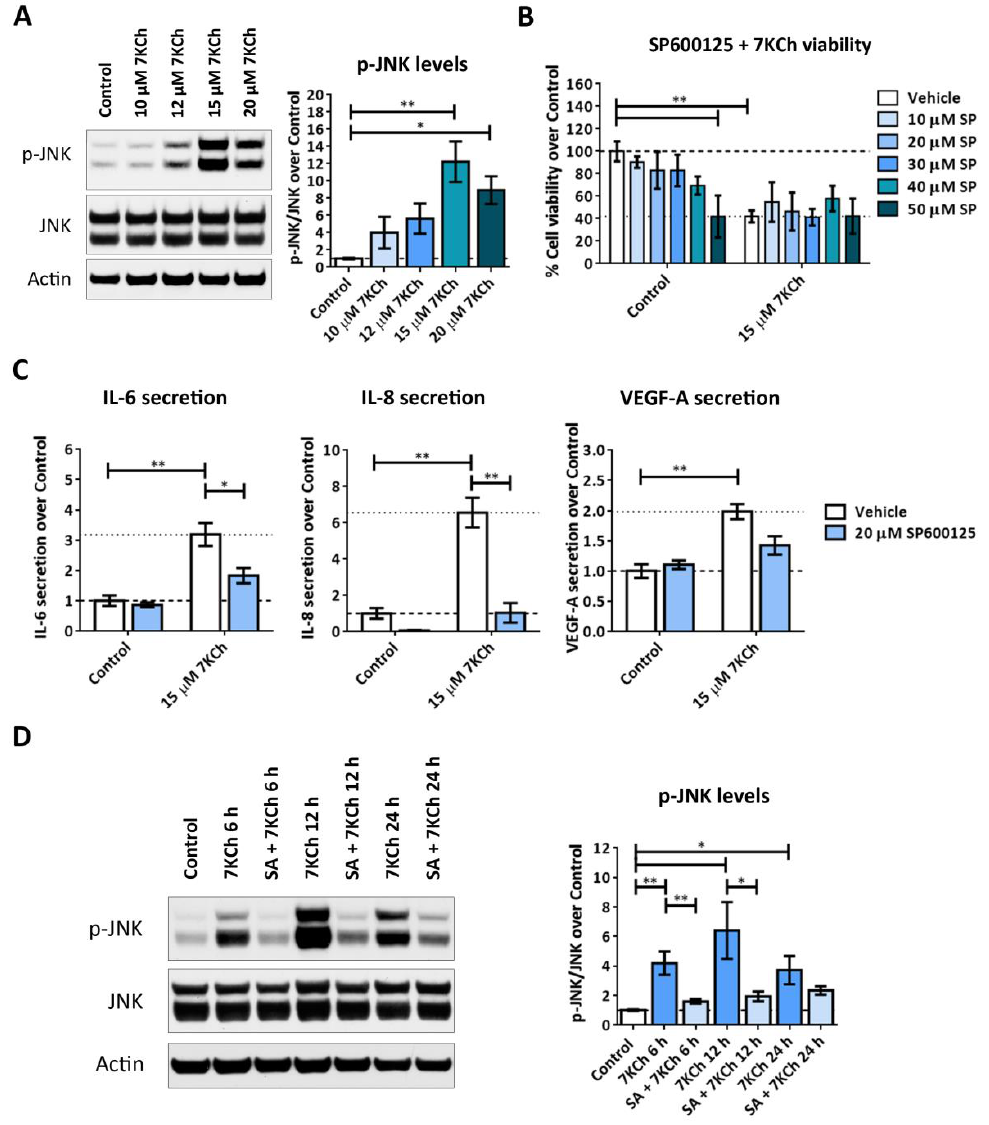
Figure 8. Activation of JNK in response to 7KCh in mRPE cells. ( A ) Western blot estimation of phosphorylated JNK (p-JNK) levels in mRPE cells exposed to increasing concentrations of 7KCh for 24 h. ( B ) Cell viability determined by MTS assay in mRPE cells treated with 15 µ M 7KCh and increasing concentrations of SP600125 (SP) for 24 h. ( C ) Secreted levels of IL-6, IL-8 and VEGF-A in mRPE cells exposed to 15 µ M 7KCh and 40 µ M SP600125 for 48 h and measured with ELISA. ( D ) Western blot estimation of p-JNK levels in mRPE cells exposed to 20 µ M 7KCh and 10 µ M SA for 6 h, 12 h and 24 h. In Western blot assays, JNK levels, previously normalized with respect to Actin, were used to normalize p-JNK quantification. In MTS assay and ELISA, the JNK inhibitor SP600125 was added with a pretreatment of 2 h with respect to 7KCh. The vehicle group in the graphs represents the control (control-vehicle) and the 7KCh (7KCh-vehicle) treatment. Data are represented as mean ± SEM of at least three different experiments. The dashed and dotted lines are a guidance mark of control and 7KCh value, respectively. ANOVA test was used for statistical analysis followed by Tukey (in A , B , D ) or Sidak (in C ) post hoc test.* p < 0.05; ** p < 0.01. Regarding p38 phosphorylation (p-p38), its activation was observed at 15 µ M 7KCh and reached its highest level at a concentration of 20 µ M. This suggests that activation of p38 may be related to both 7KCh-induced inflammation and cell death in mRPE cells.